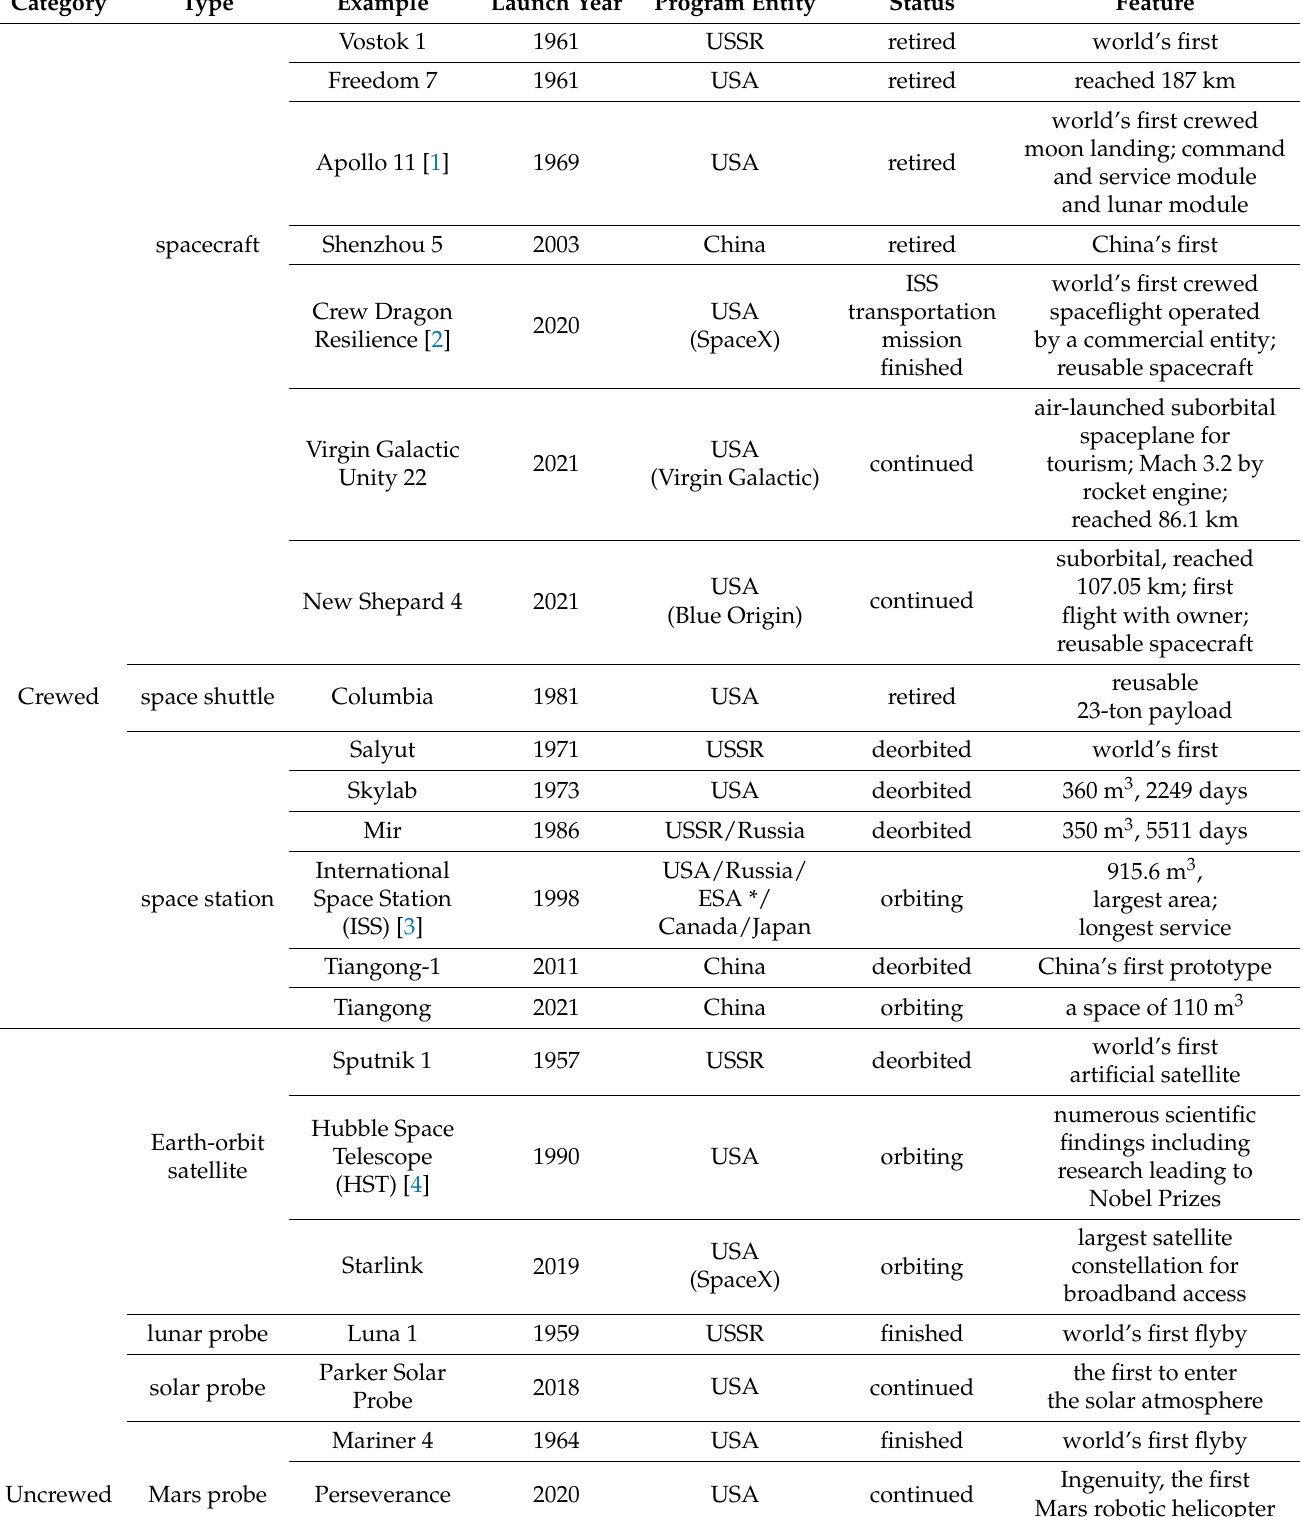
Table 1. A summary of some crewed and uncrewed generalized